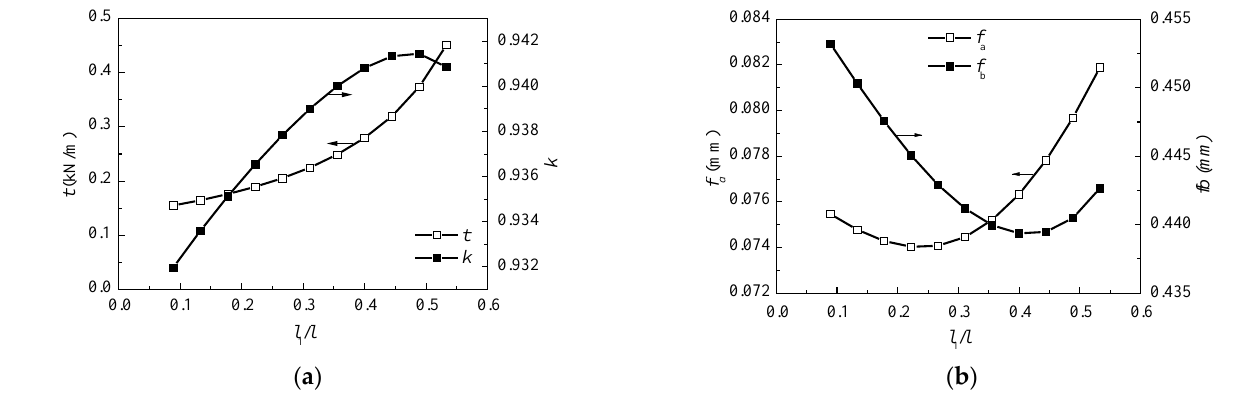
Figure 10. ( a ) Relationships between l 1 / l and t , k ; and ( b ) the relationships between l 1 / l and f a , f b . The two curves correspond to different y coordinates, the arrow shows the y coordinate. the cables stay the same, l 3 varies from 18 m to 58 m by reducing the outmost cables.